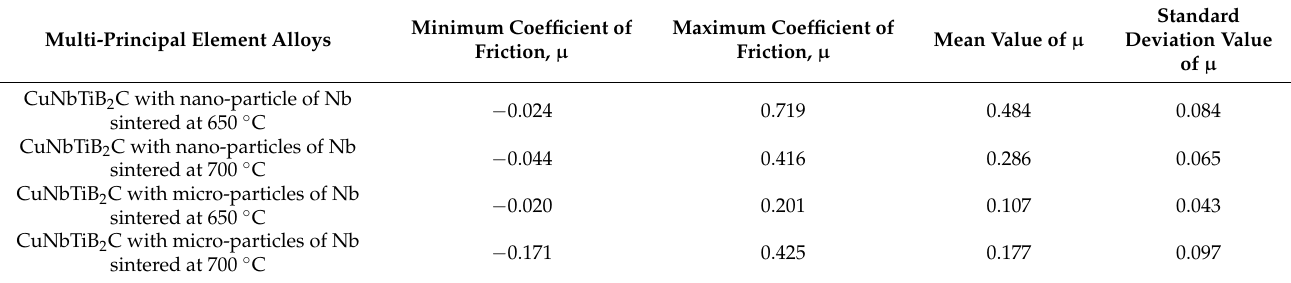
Table 3. Summary of the wear behavior of the produced multi-principal element